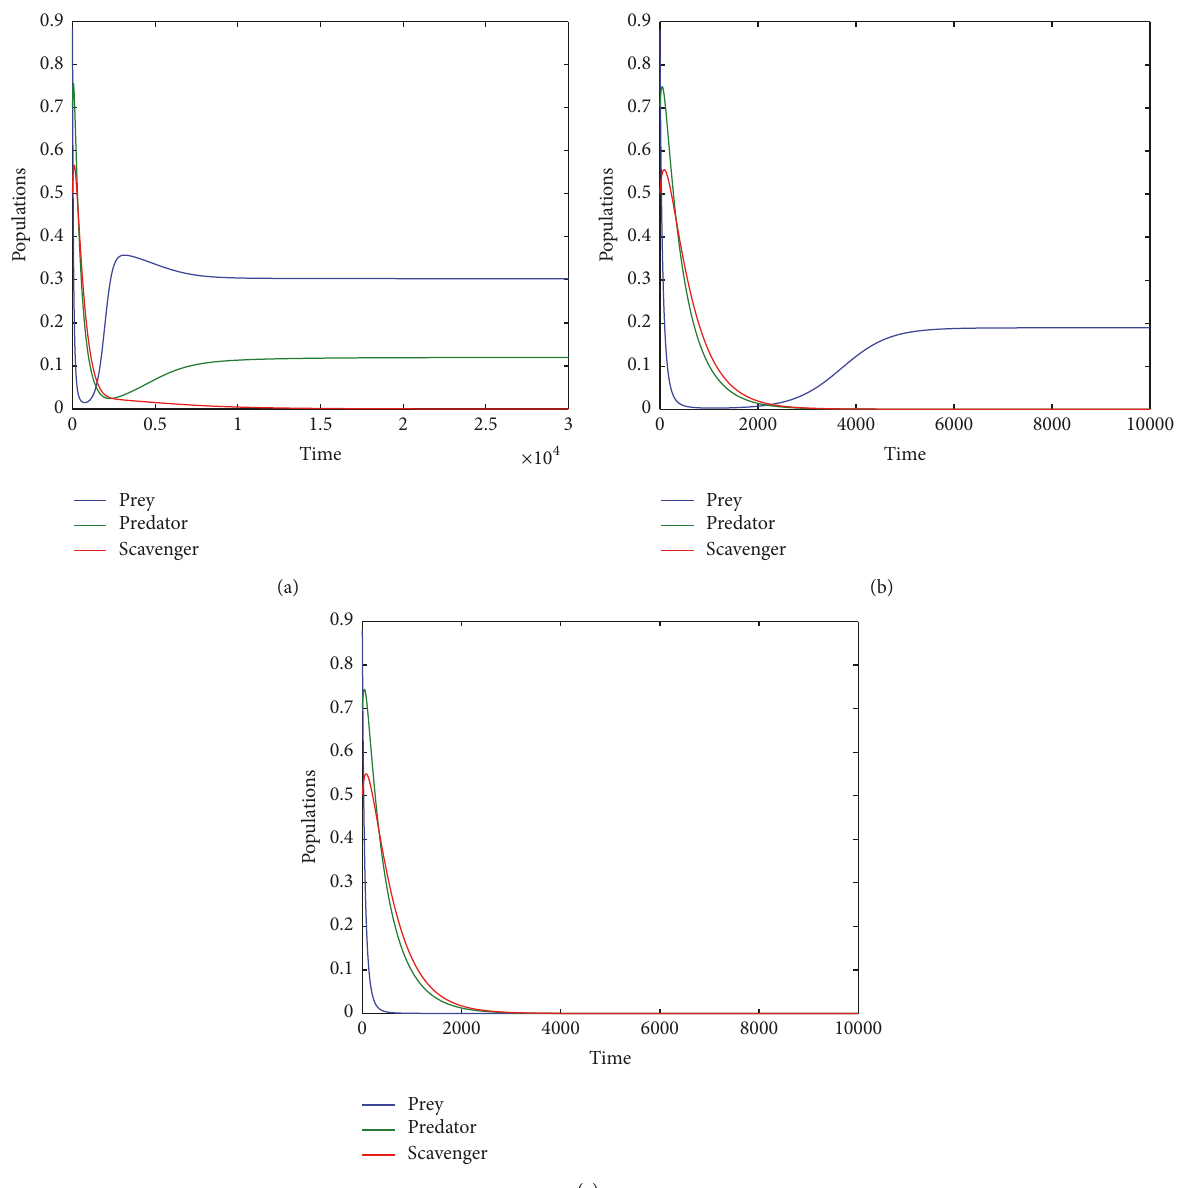
Figure 3: Time series for the solution of system (3) using data (76) with typical values of 𝛼 . (a) The system approaches scavenger free equilibrium point 𝐸 2 = (0.3,0.12,0) when 𝛼 = 0.55 . (b) The system approaches axial equilibrium point 𝐸 1 = (0.19,0,0) when 𝛼 = 0.8 . (c) The system approaches trivial equilibrium point 𝐸 0 = (0, 0, 0) when 𝛼 = 1.01 .